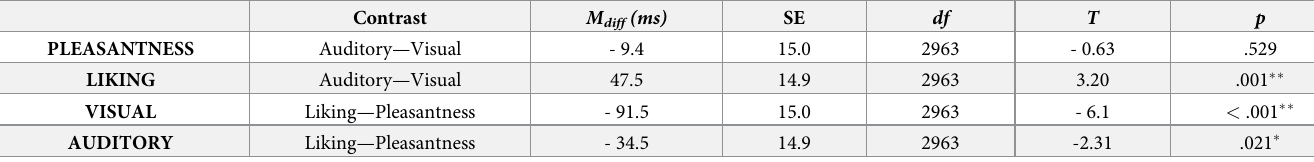
Table 3. Pairwise differences of modalities within tasks and pairwise differences of tasks within modalities of model 4i. Contrast